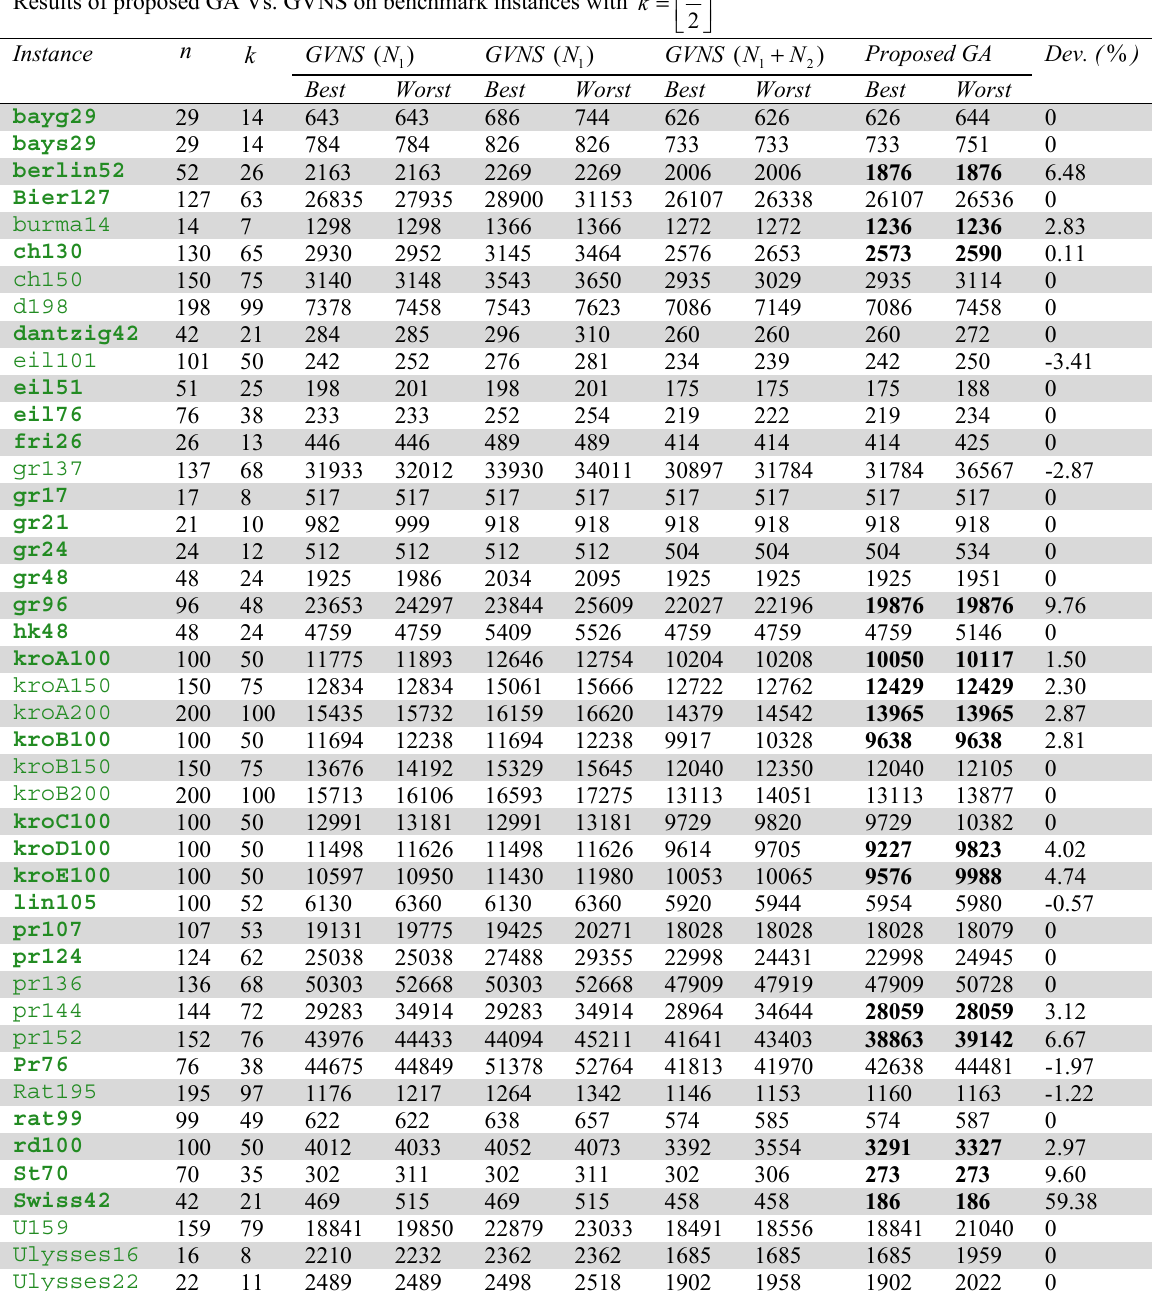
Results of proposed GA Vs. GVNS on benchmark instances with